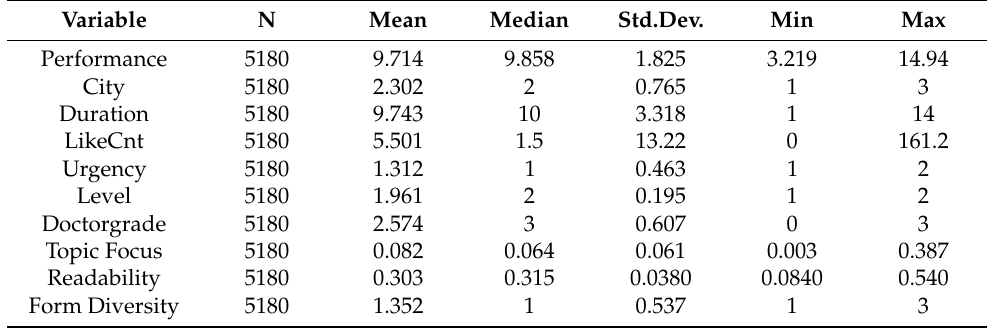
Table 3. Results of Descriptive Statistics of